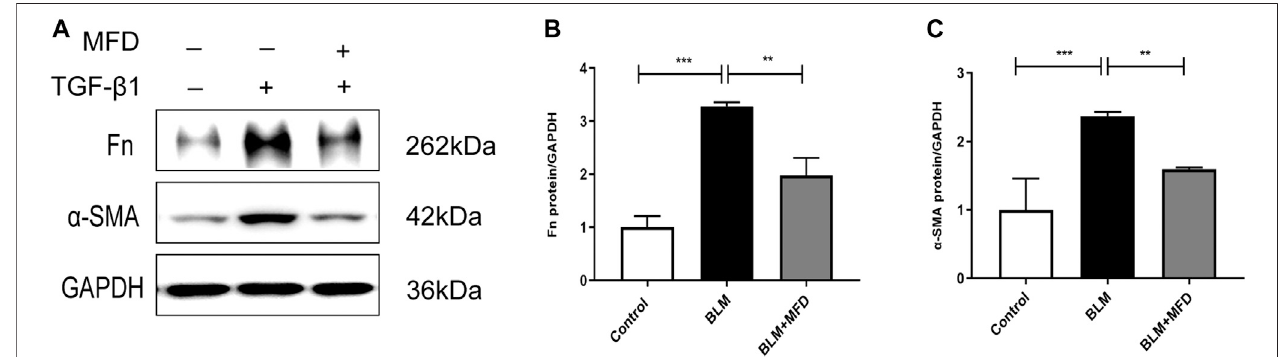
FIGURE 8 | Mefunidone inhibited the formation of extracellular matrix in fi broblast (A – C) : Western blots (A) and quantitative analysis of fi bronectin (B) and α -SMA (C) in normal human lung fi broblasts (NHLF) treated with TGF- β 1 (10 ng/ml) with/without mefunidone (40 μ g/ml) pretreatment. All experiments were conducted with more than three independent replication. Data were presented as mean ± SD. ANOVA was used for comparison in (B – C) . ** p < 0.01; *** p <